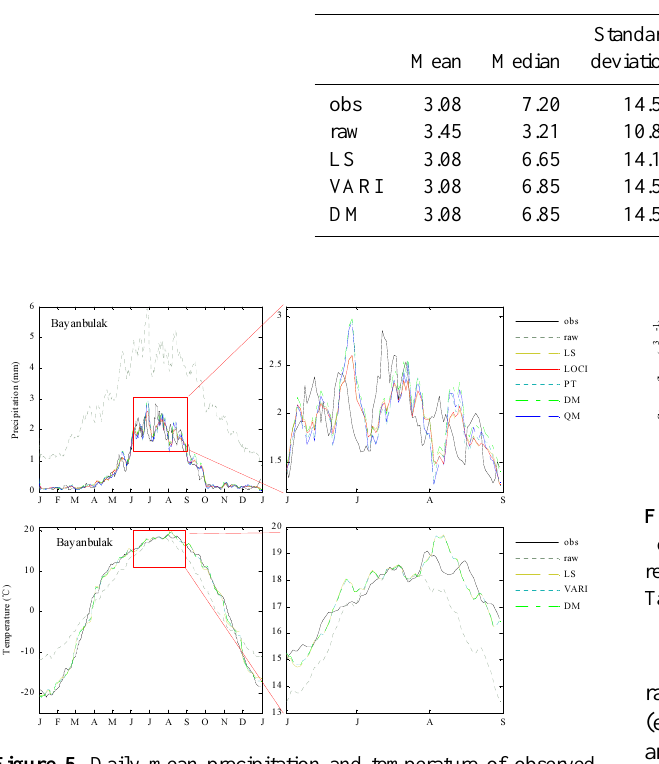
Figure 5. Daily mean precipitation and temperature of observed (obs), raw RCM-simulated (raw), and bias-corrected values at Bayanbulak Station, which were smoothed with the 7-day moving average method. The precipitation and temperature during May– August is amplified to inspect the performance of each correction method.